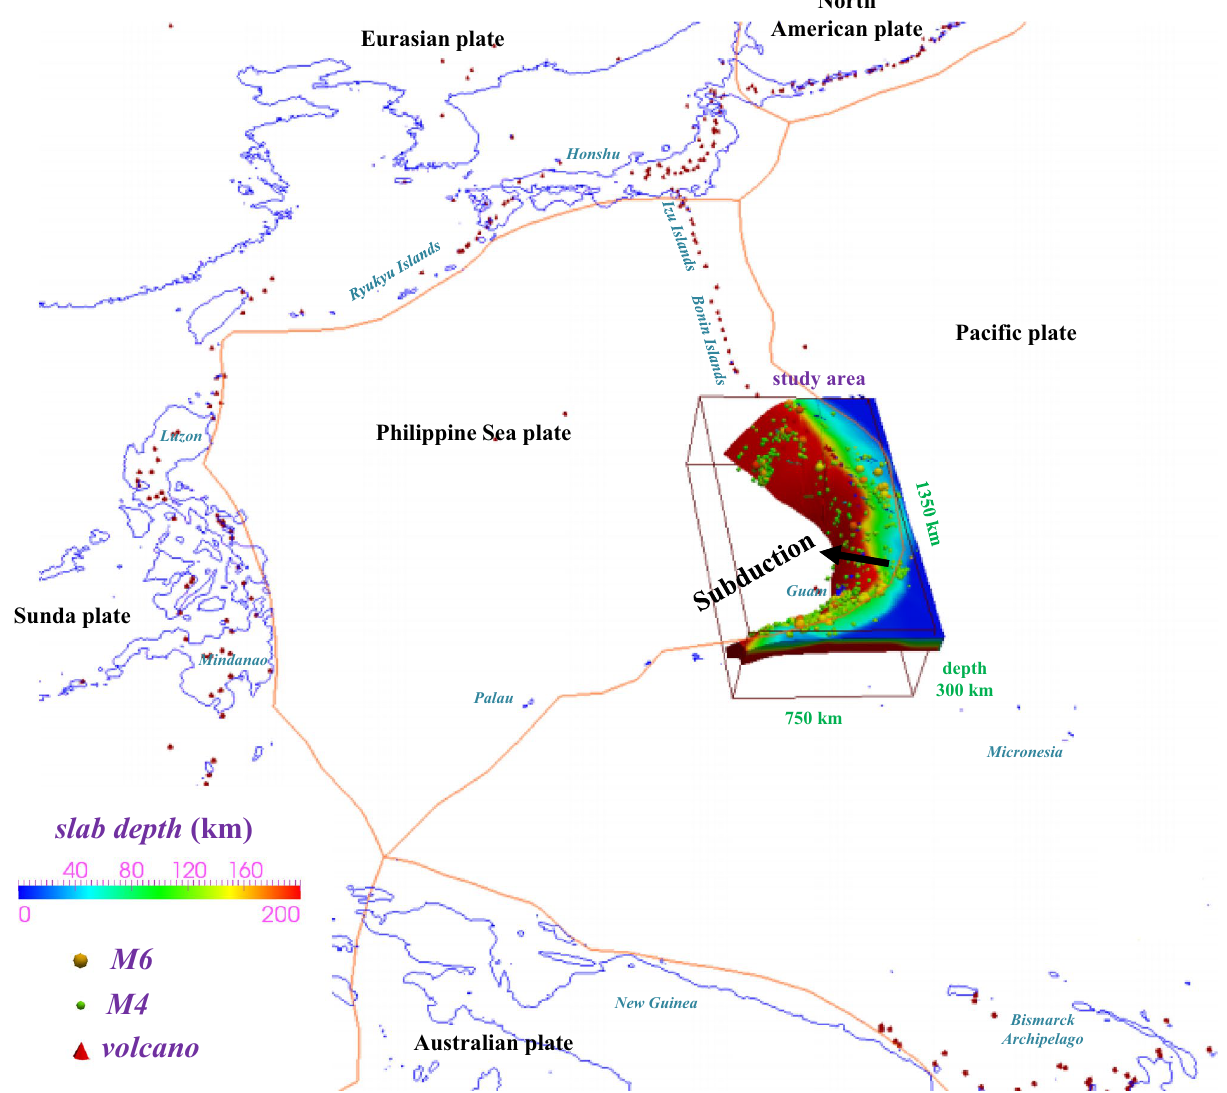
Figure 2. Model domain in the tectonic setting, including the model size, plate boundaries and arc volcanism. The plate boundaries follow Bird (2003) 22 . Red cones indicate active arc volcanoes 21 . The figure was created